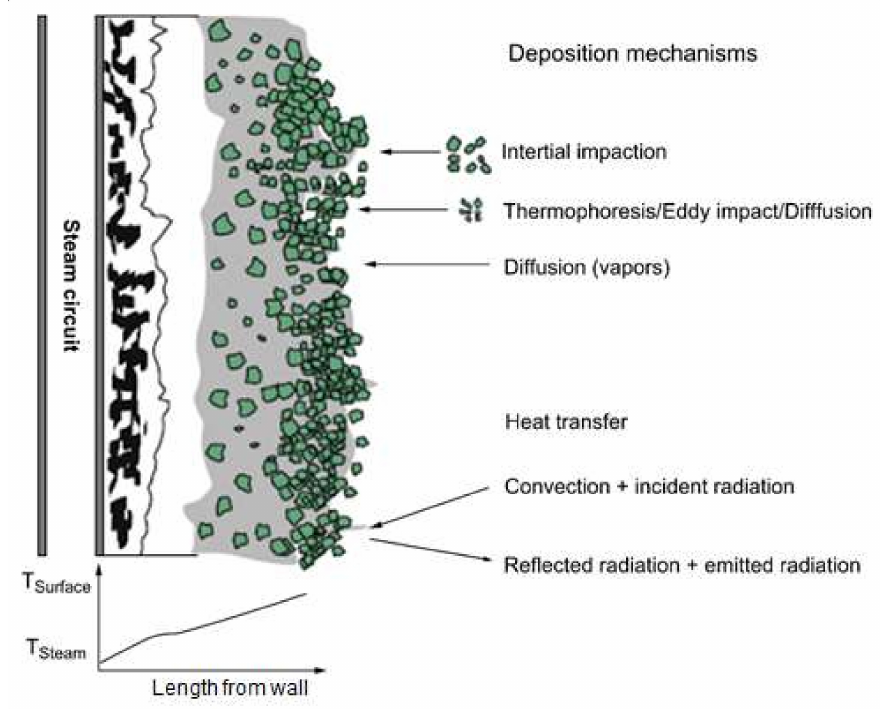
Figure 4. Conceptual illustration of mechanisms of ash deposition on the walls of a furnace